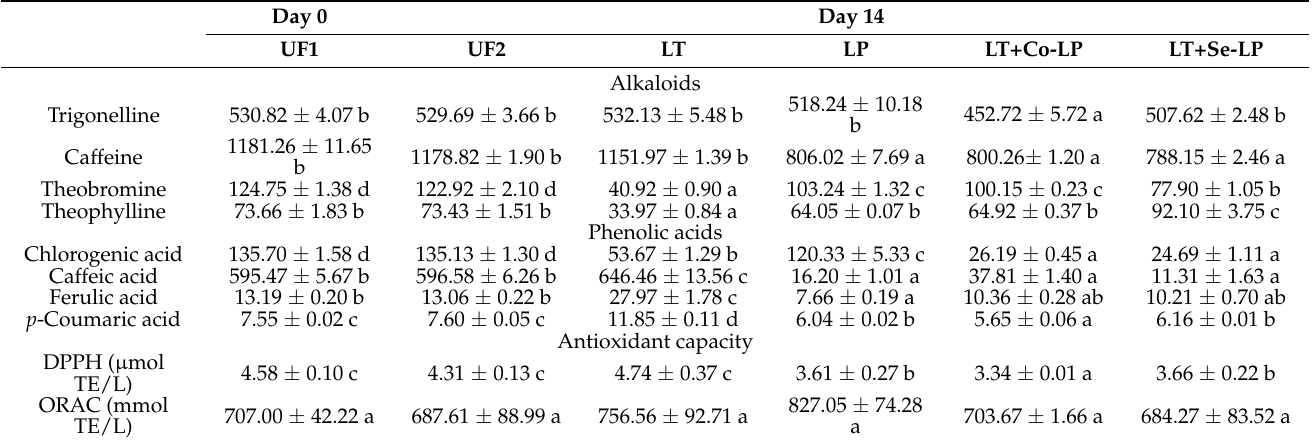
Table 2. Changes in alkaloids, phenolic compounds, and antioxidant capacity in SCG hydrolysates before and after fermentation with L. thermotolerans and L. plantarum